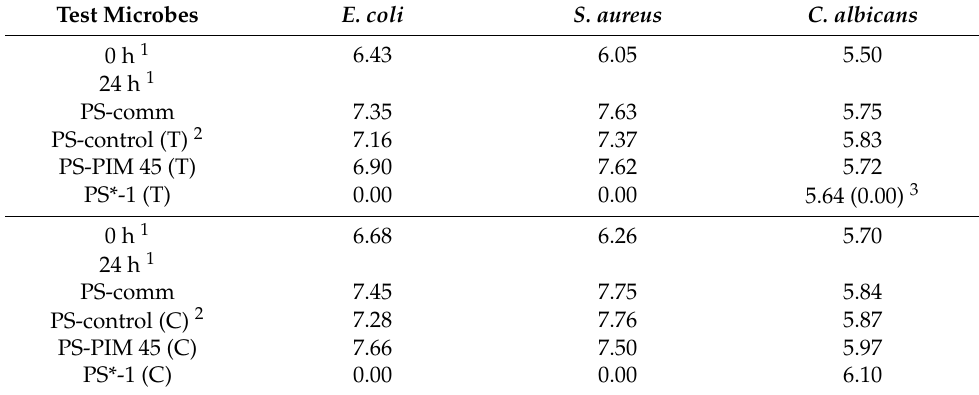
Table 1. Antimicrobial activities of PS controls, PS-PIM 45, and PS*-1 film surfaces (JIS Z 2801/ISO 22196